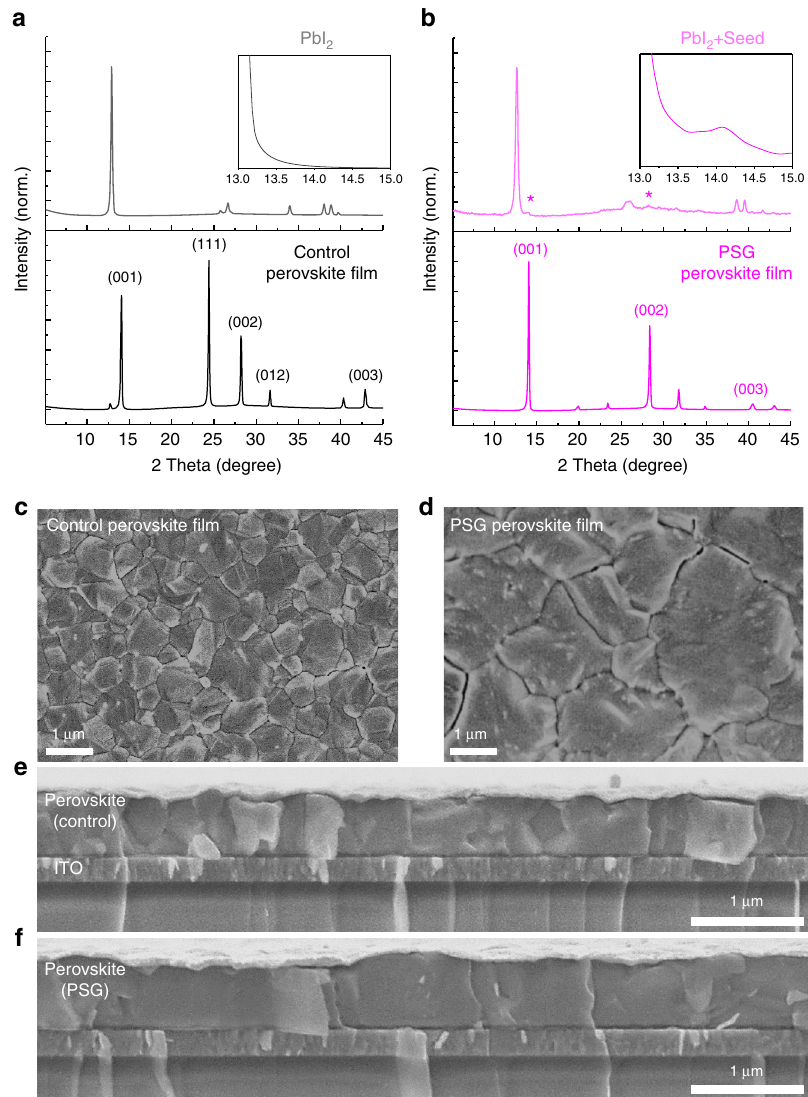
Fig. 4 Structural and morphological characterization of perovskite fi lms. a XRD patterns of pure PbI 2 fi lm and the as-prepared control perovskite fi lm. The inset is a zoom-in of the XRD spectrum in the range 13° – 15°. b XRD patterns of the PbI 2 fi lm with 14 vol.% perovskite seed and the as-prepared PSG perovskite fi lm. The inset is a zoom-in of the XRD spectrum in the range 13 o – 15 o . c – d Top-view SEM images of the control and PSG perovskite fi lms. e , f Cross-sectional SEM images of the control and PSG fi